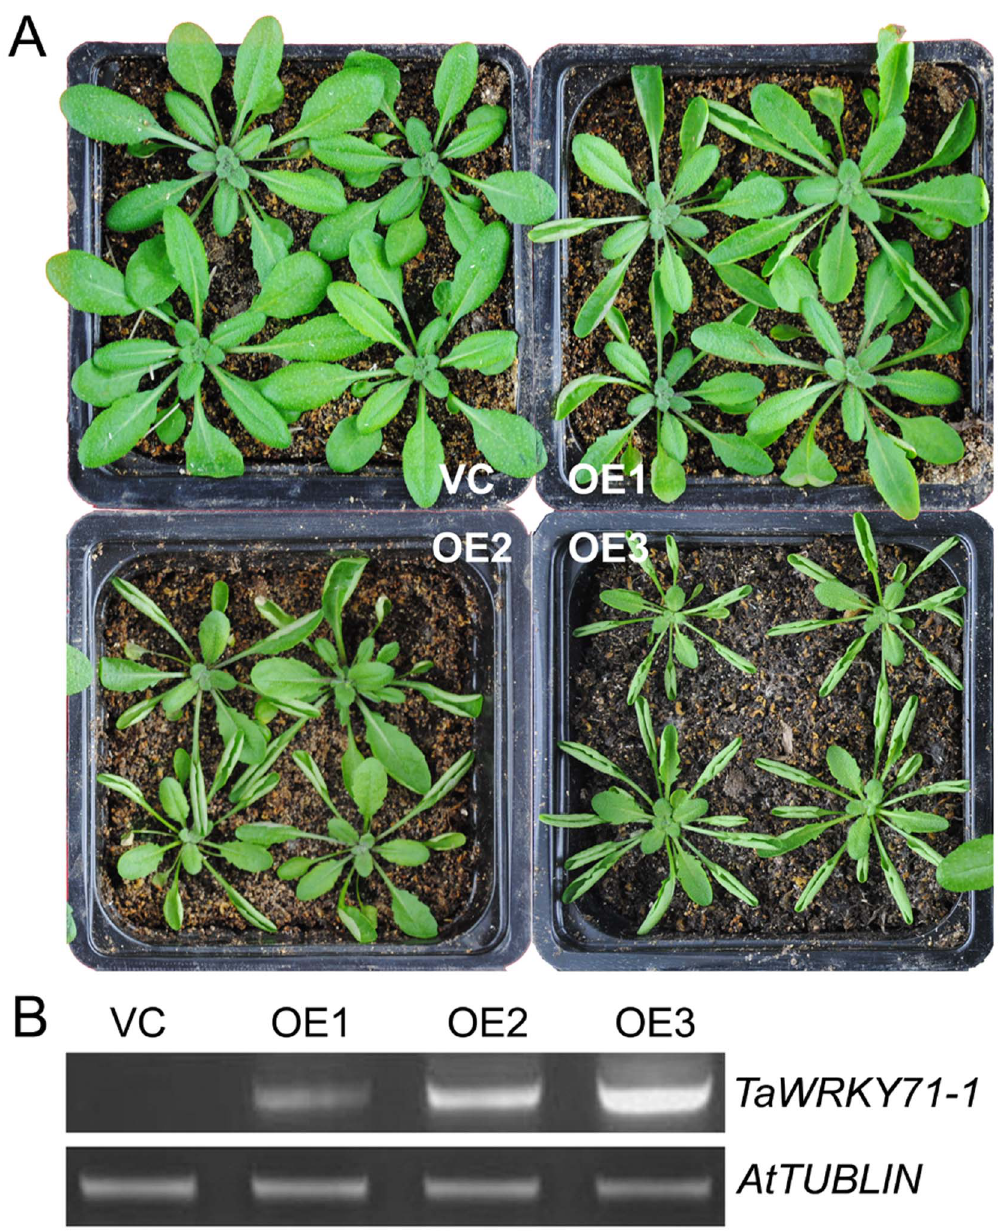
Figure 5. TaWRKY71-1 overexpression results in hyponastic leaves in Arabidopsis . A: Phenotypic comparison of four-week old Arabidopsis seedlings. B: sqRT-PCR of transgenic TaWRKY71-1 in Arabidopsis , and an Arabidopsis tublin gene was used as the internal reference. Col-0, the ecotype Columbia-0; VC, Vector control; OE1–3, three independent transgenic Arabidopsis lines overexpressing TaWRKY71-1 .